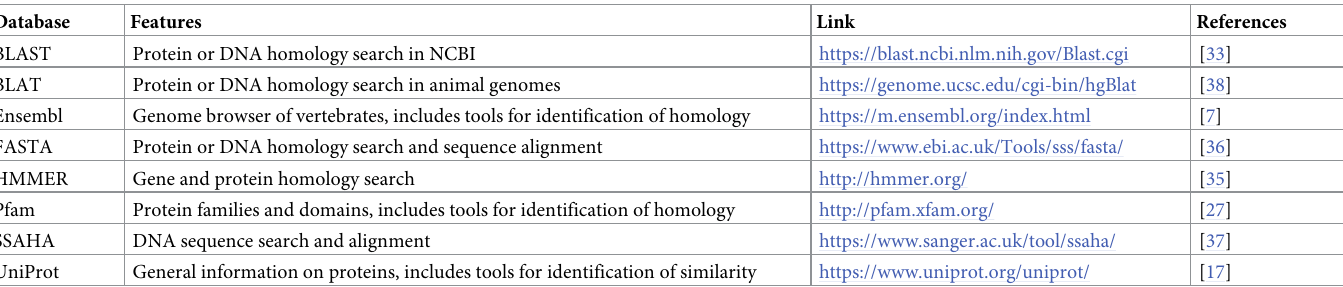
Table 3. List of bioinformatic tools for identification of gene and protein homologues.